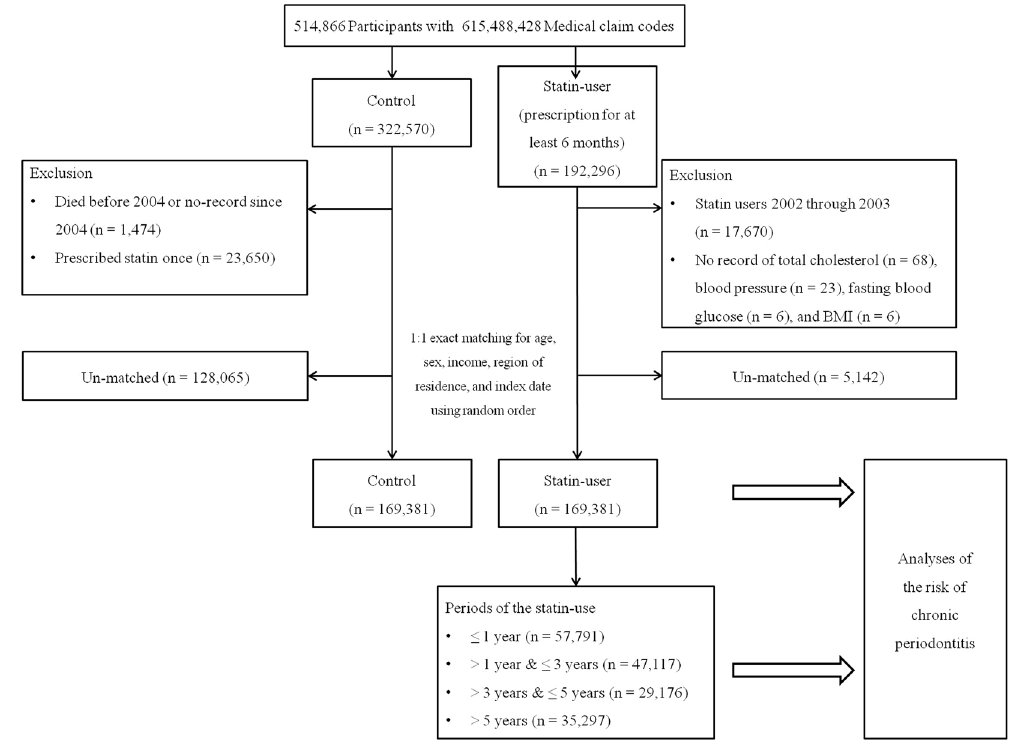
Figure 1. A schematic illustration of the participant selection process that was used in the present study. Of a total of 514,866 participants, 169,381 of the statin-user group were matched with 169,381 of the control group for age, gender, income, and region of residence. Statin-user group was subclassified according to the periods of statin-use as follows: ≤ 1 year (n = 57,791), > 1 year & ≤ 3 years (n = 47,117), > 3 years & ≤ 5 years (n = 29,176), and > 5 years (n = 35,297). Abbreviations: BMI, body mass